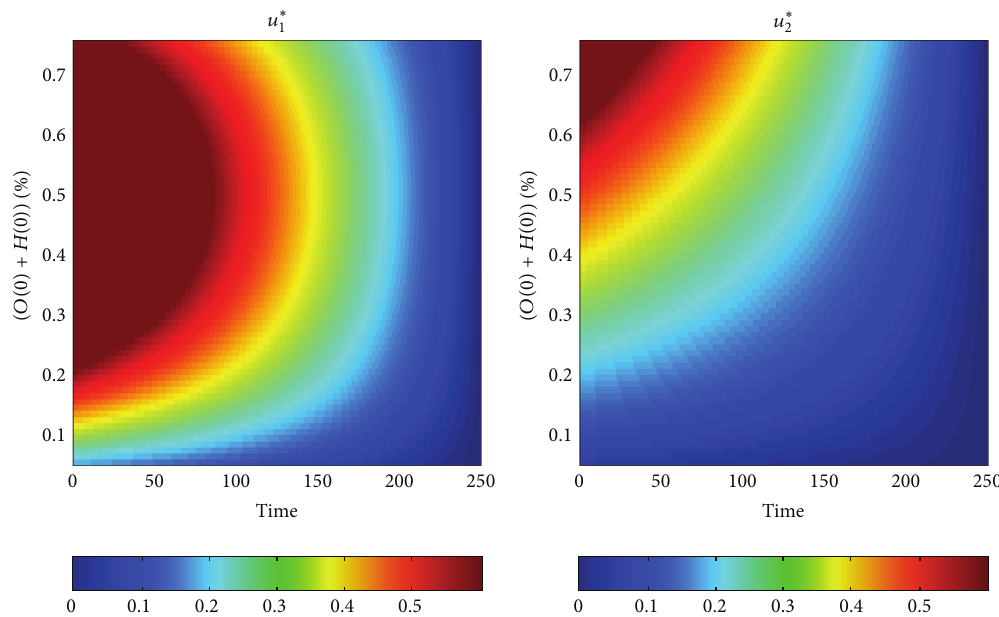
Figure 5: Optimal control scenario for wide range of initial obesity burden with 𝐵 1 = 50 and 𝐵 2 =